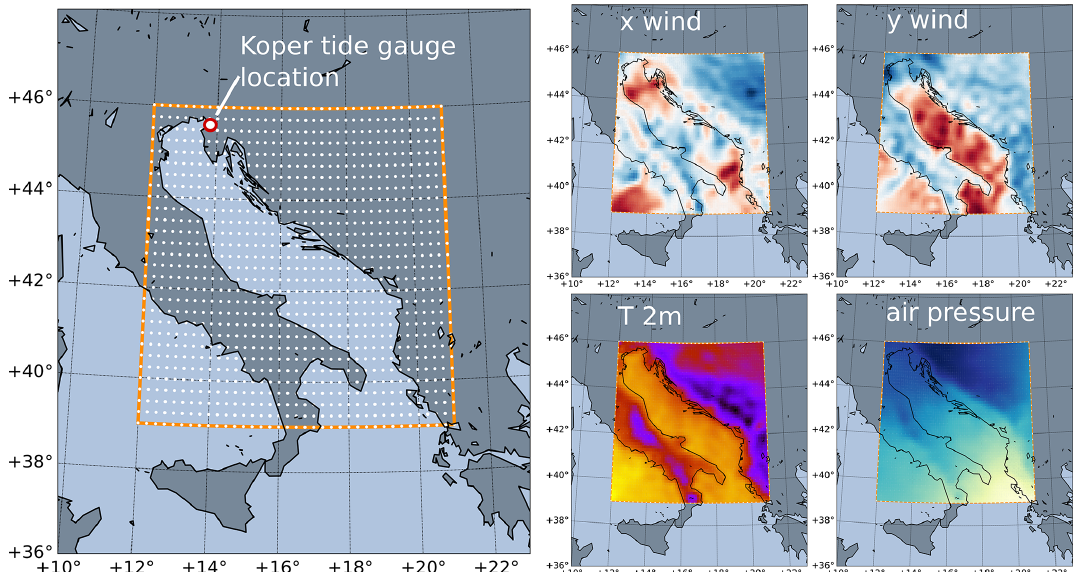
Figure 2. Left: NEMO ocean model domain (orange rectangle) and ECMWF ensemble grid points (white dots). Every second ECMWF grid point is displayed for clarity. Koper tide gauge location is marked with a red–white circle. Right: four ECMWF atmospheric fields are extracted over the region at each time step: zonal ( x ) and meridional ( y ) wind, air temperature at 2m and surface air